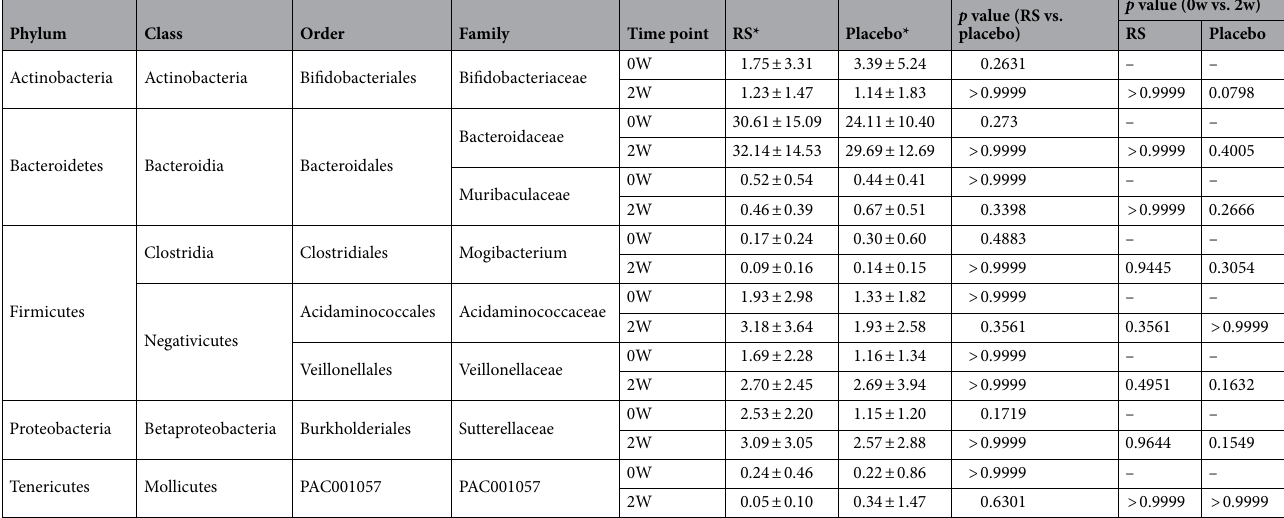
Table 2. Families altered during human study. *The values indicate